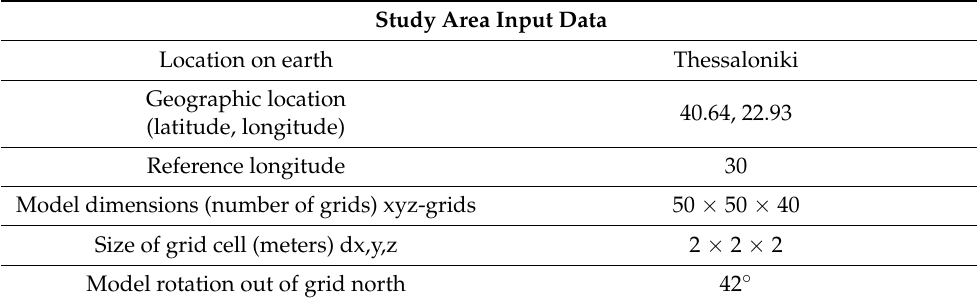
Table 2. Input data of the study area in ENVI-met© software. (The meteorological factors come from https://www.meteo.gr/ (accessed on 9 December 2020) [48], and the human parameters were randomly selected.)